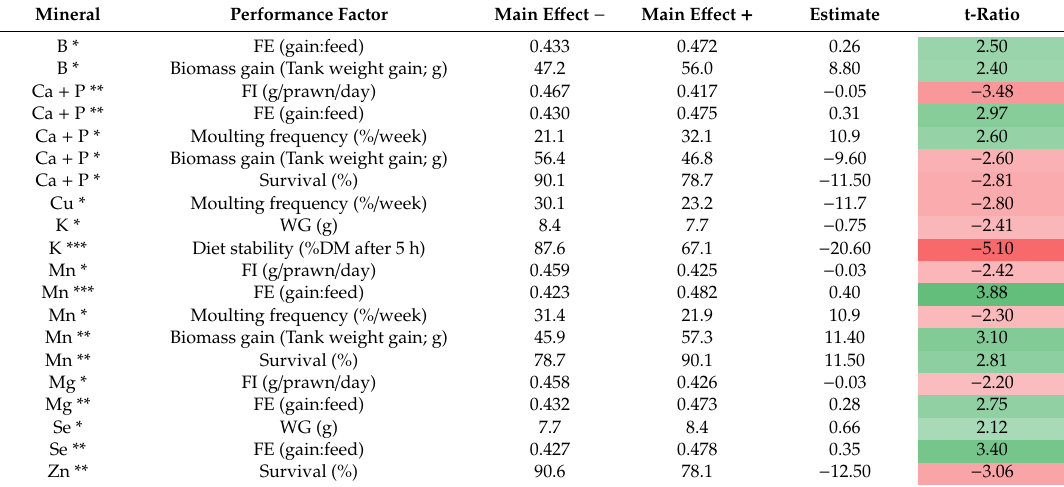
Table 5. E ff ect of significant mineral inclusions on growth performance parameters including WG (g) 1 , FI (g / prawn / day) 2 , FE (gain:feed) 3 , moulting frequency (% / week) 4 , biomass gain (g) 5 , survival (%) 6 at Day 42 and diet stability (%DM after 5 h) 7 using a two-level screening analysis. p -values are denoted by an asterisk (* p < 0.05, ** p < 0.01, *** p < 0.001). t-ratios of minerals highlighted green have a positive e ff ect and red have a negative e ff ect on the performance parameter where the shading reflects the magnitude (i.e., darker shading has a higher magnitude of e ff ect and vice versa).